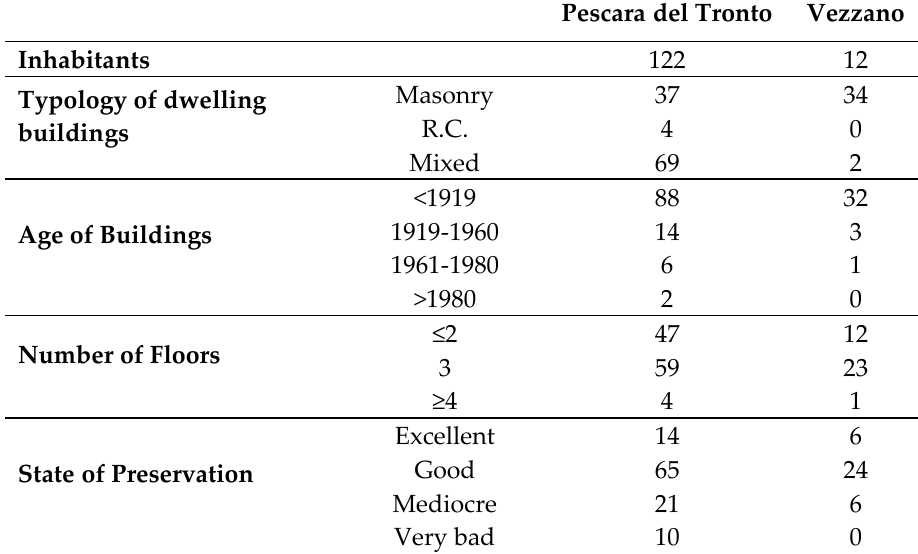
Table 1: Data extracted from the 2011 Italian population and housing census (ISTAT,